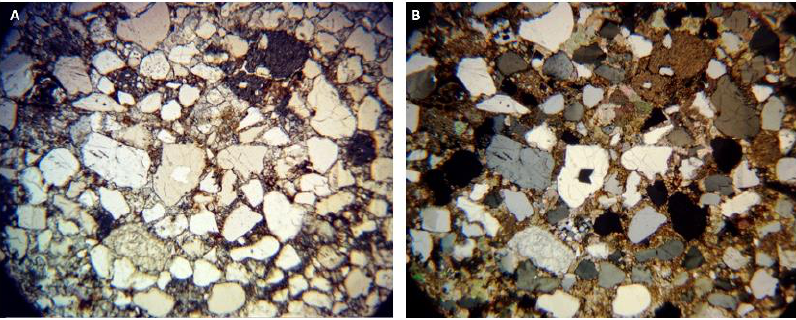
Figure A8. Plate E1: Petrographic images of sandstone sample (SS-10) under plain ( A ) and polarized ( B )